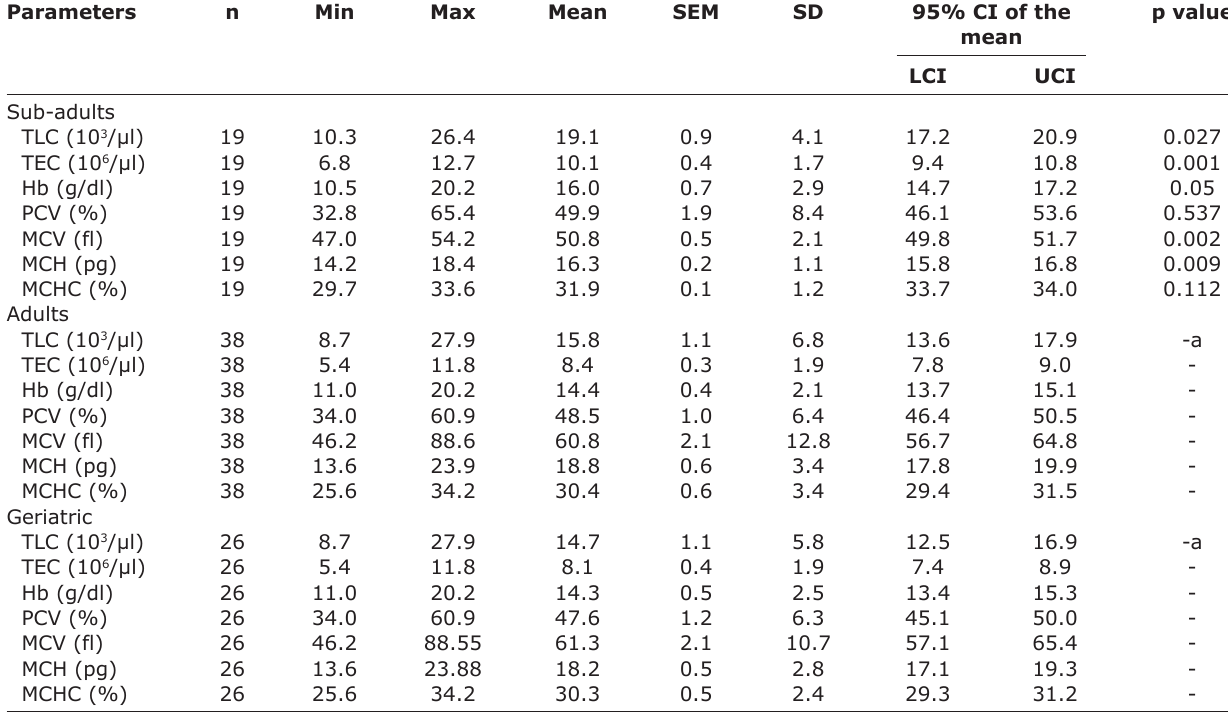
a p values for sub-adult, adult and geriatric group comparison are listed in the top (sub-adult) half of the table. TLC=Total leukocyte count, TEC=Total erythrocyte count, Hb=Hemoglobin, PCV=Packed cell volume, MCV=Mean corpuscular volume, MCH=Mean corpuscular hemoglobin, MCHC=Mean corpuscular hemoglobin concentration, CI=Confidence interval, LCI=Lower confidence interval, UCI=Upper confidence interval, BBP=Bannerghatta Biological